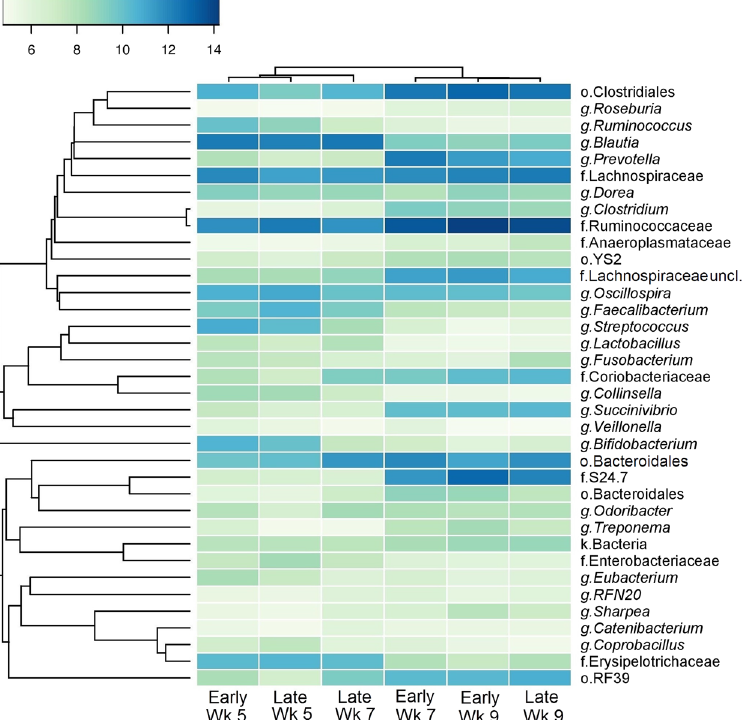
Figure 4. Correlation between faecal microbiota and calf age and weaning strategy. The heatmap shows bacterial abundance in faeces varied with calf age (5, 7 and 9 weeks) and weaning age (6 vs. 8 weeks for early- and late-weaning, respectively). Data presented represent taxa present at greater than 1% of community that were significantly different (P < 0.05) between at least two ages or between treatment groups (weaning age). See Table S2 for additional data. The OTU count data was subjected to variance stabilising transformation and summarised to calculate genus abundant data. Hierarchically clustering was then performed based on complete linkage of Euclidean distances matrix and visualised over heatmap using the heatmap.2 function of the “gplots” R